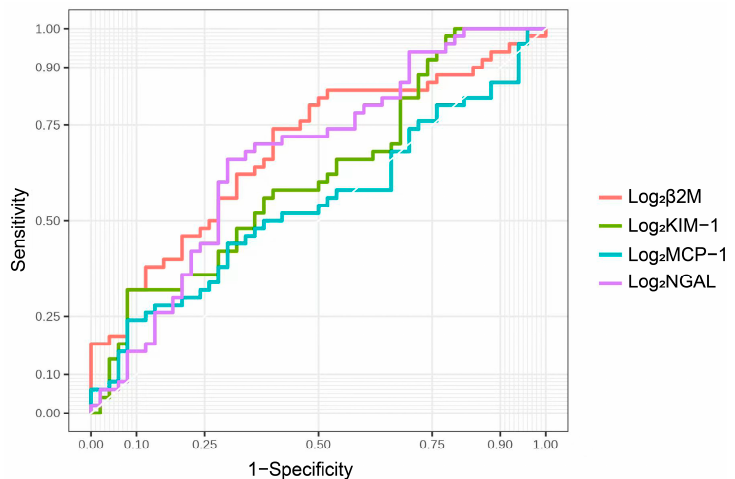
Figure 4. ROC curve analysis of single urinary biomarkers of renal tubular injury.